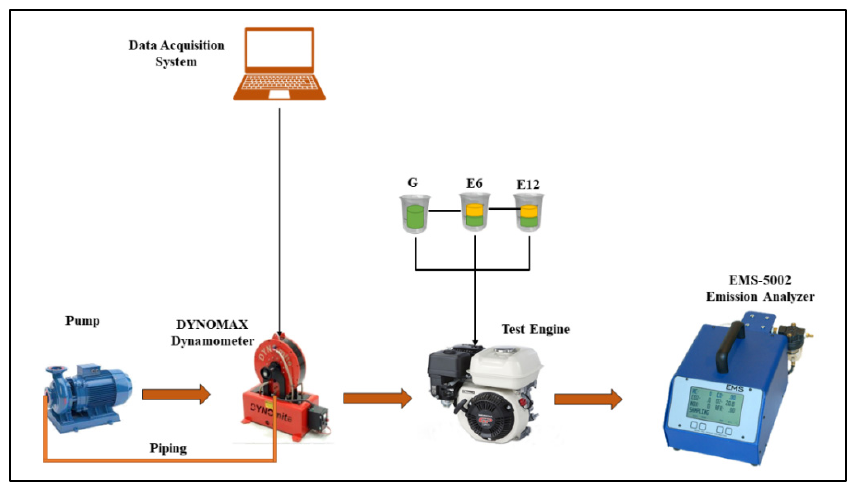
Figure 1. Schematic of experimental setup.